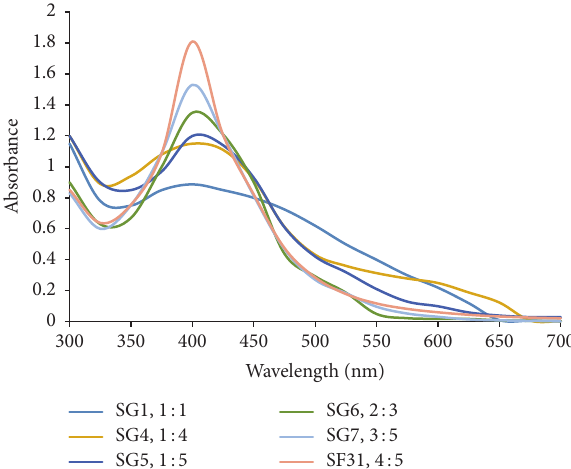
Figure 3: Showing spectra of WMRE-AgNPs samples SG1, SG4, SG5, SG6, SG7, and SF31 under optimized conditions of temperature (80 ∘ C) and pH 10.